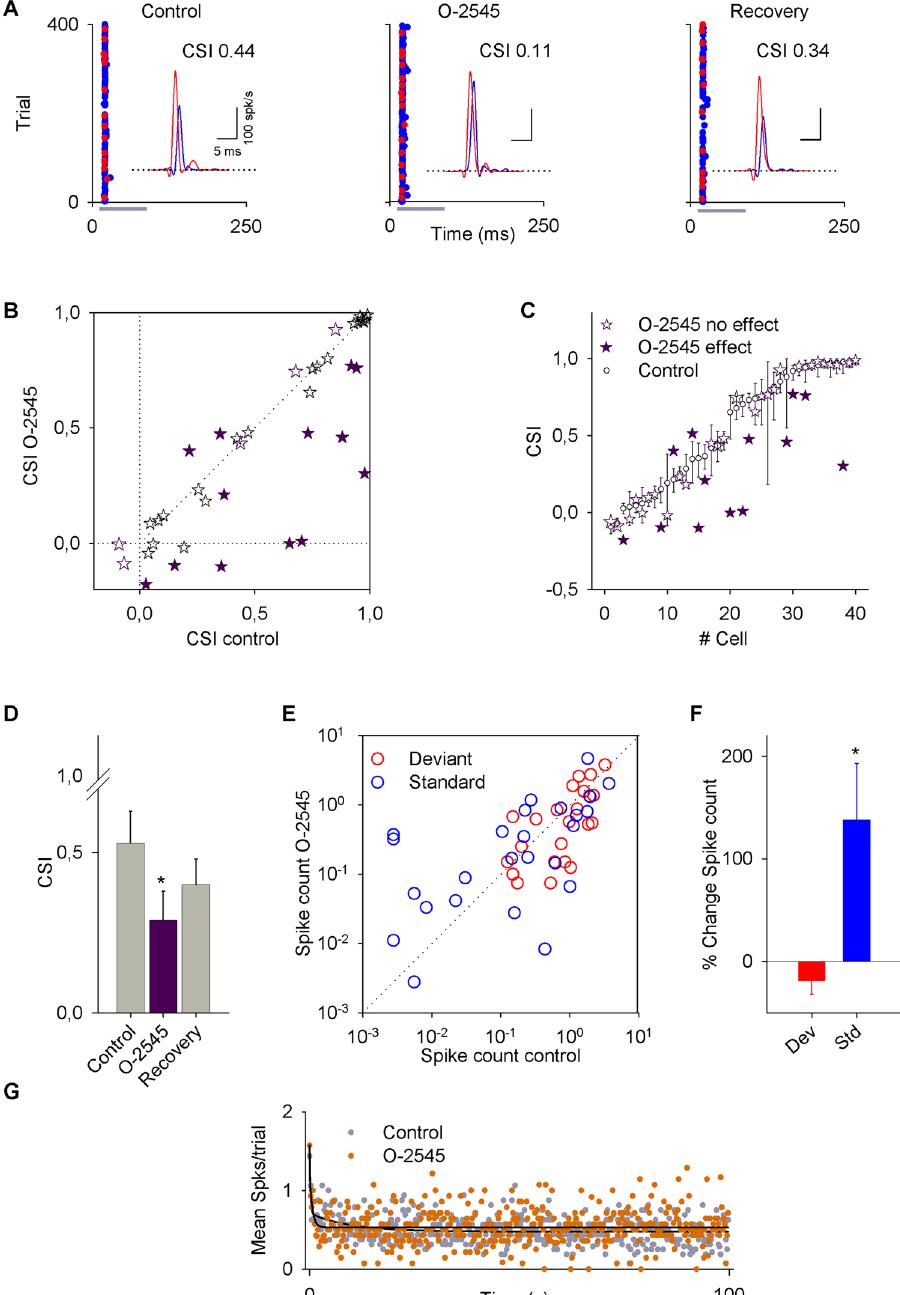
Figure 3. Effect of O-2545 on the activity of IC neurons. ( A ) Typical recording of an IC neuron under an oddball stimulation paradigm before (control), during (O-2545), and after (recovery) microiontophoretic application of O-2545. (For this neuron, the standard frequency was 34544 Hz and the deviant frequency was 28284 Hz.) Insets represent the PSTH of the response in which the CSI decreased from 0.44 to 0.11 and recovered to 0.34. ( B ) Scatter plot of the CSI in the control condition versus O-2545 application. The CSI of most of the neurons decreased. ( C ) Bootstrapping analysis for each neuron recorded in control condition (white dots) and with O-2545 application (purple stars: significant change; white stars: no change). ( D ) Bars represent the averaged CSI ± SE of the neurons in which there were significant changes. ( E ) Scatter plot of the spike count in control condition versus drug application for deviant (red dots) and standard (blue dots) stimuli. ( F ) Bars represent the percent change in the spike count for deviant (red bar) and standard (blue bar) stimuli. Vertical bars represent the % change ± SE. ( G ) Time course of adaptation of O-2545. The baseline (gray circles) and O-2545 data (orange circles) had fast and slow decay components and a steady-state component that were fitted by a double exponential function (black